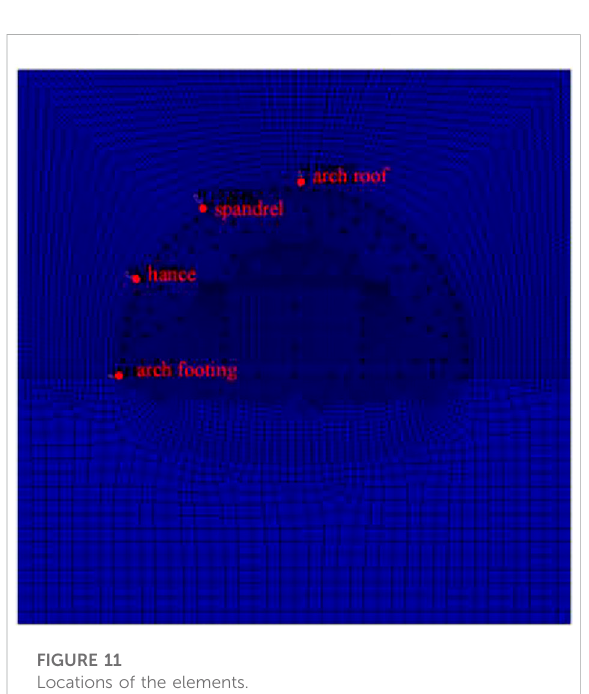
FIGURE 11 Locations of the